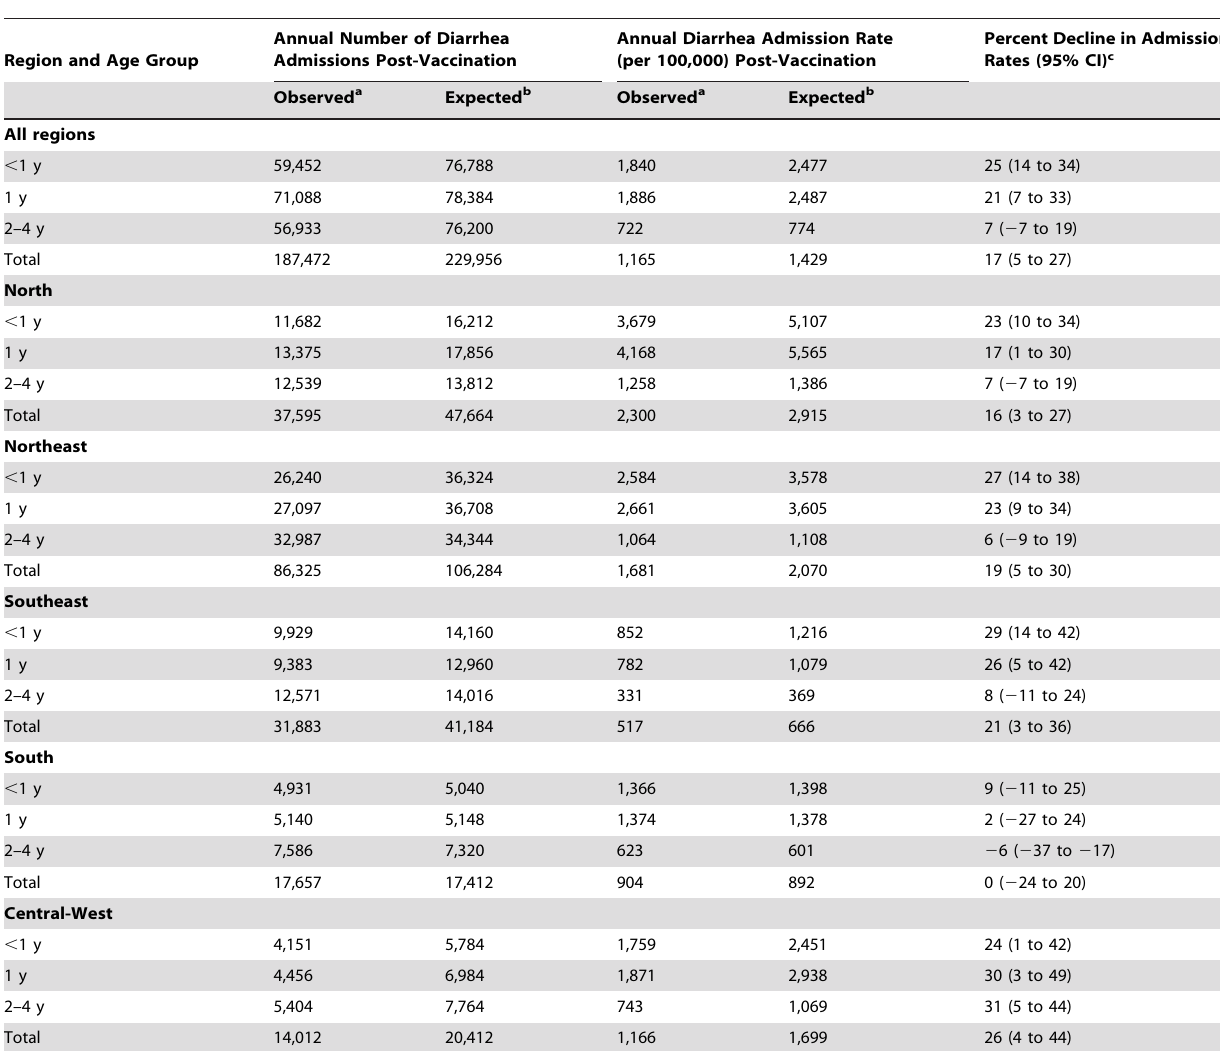
Table 3. Changes in number and rates of hospital admissions for diarrhea due to all causes among children , 5 y by December, 2009,